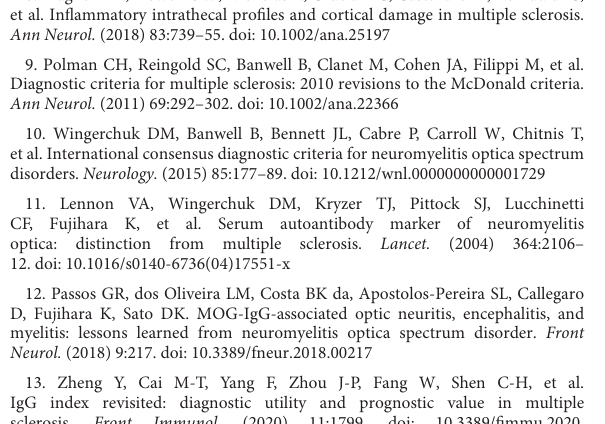
SUPPLEMENTARYFIGURE2 Correlation of CSF inflammatory parameters with EDSS at sample collection. Scatterplot graphs of the linear regression analysis showed the relation between cytokine/chemokine levels in CSF and EDSS at sample collection. Strengths of the associations are given in R 2 values. CSF, cerebrospinal fluid; MS, multiple sclerosis; NMOSD, neuromyelitis optica spectrum disorder; EDSS, Expanded Disability Status Scale.